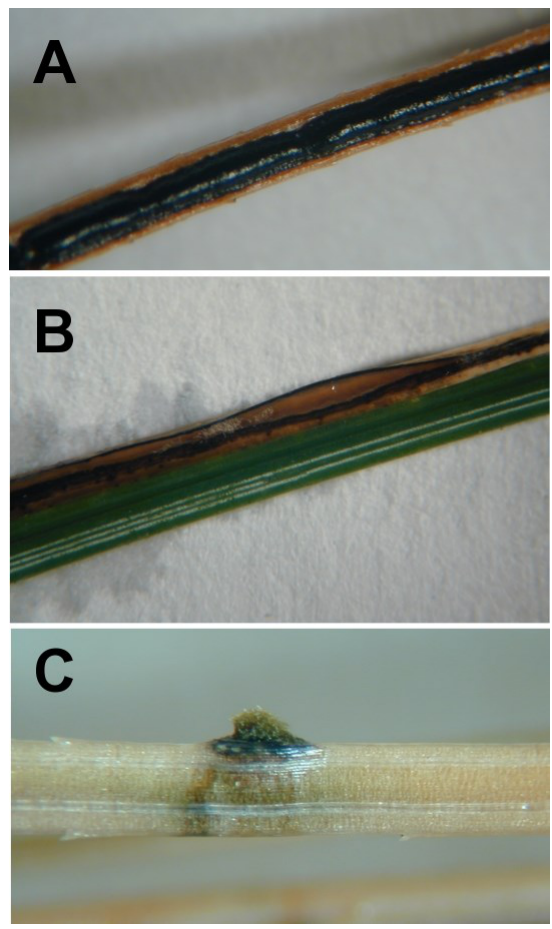
Figure 2. Disease symptoms and reproductive structures of ( A ) Bifusella linearis ; ( B ) Lophophacidium dooksii ; and ( C ) Lecanosticta acicola on eastern white